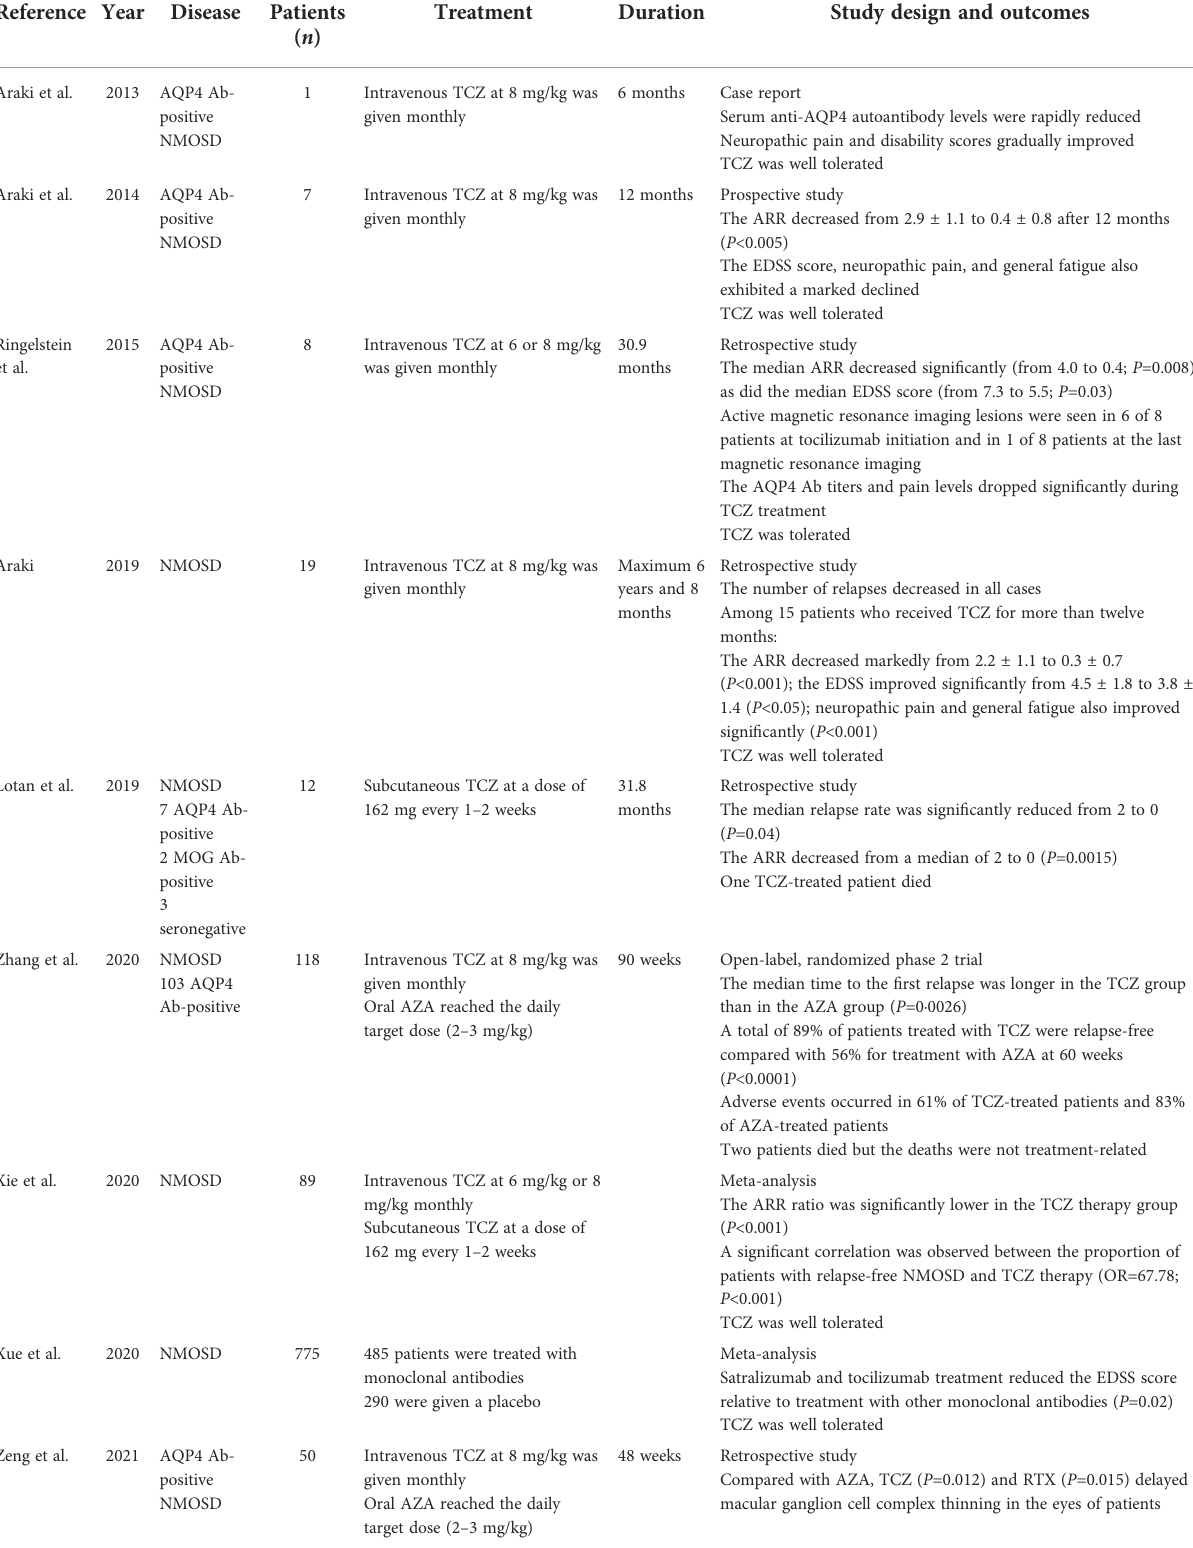
TABLE 1 Summary of the main clinical trials on tocilizumab and satralizumab in central nervous system in fl ammatory demyelinating